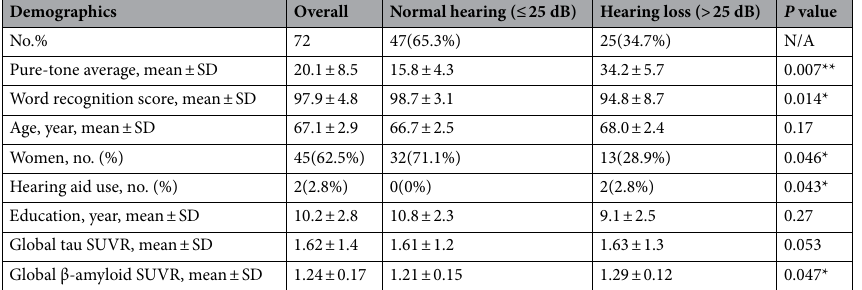
Table 1. The demographic and audiological variables of subjects included in the analyses. For continuous variables, t tests were indicated, and for categorical variables, χ 2 tests or fisher exact were used. SD standard deviation, N/A not applicable, SUVR standardized uptake value ratio. *Significant, P < 0.05.